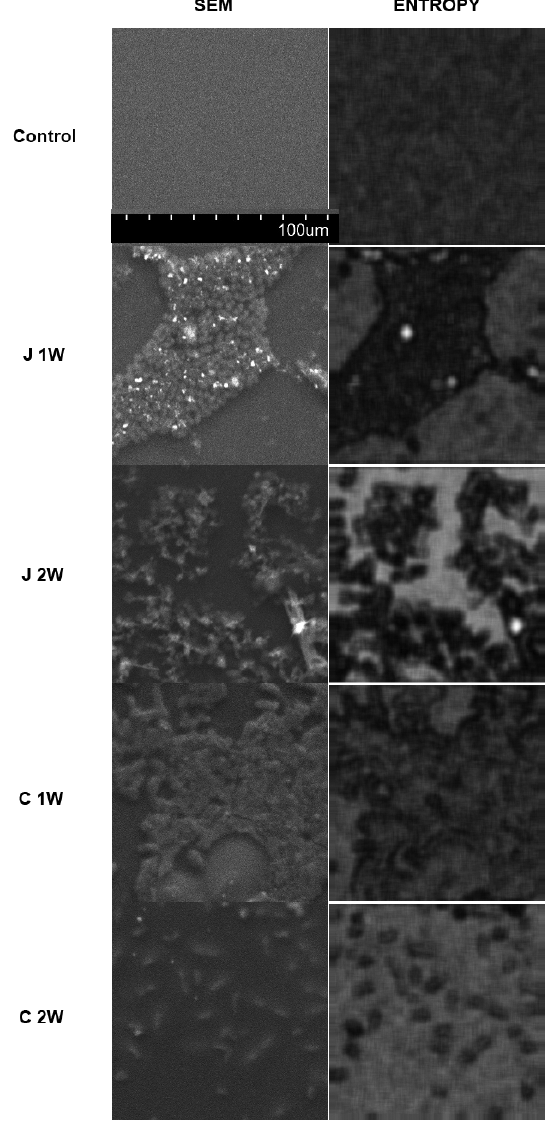
Figure 2. Investigation of surface structures on orthodontic alignments using digital texture analysis. The left column shows images from scanning emission microscopy (SEM). The right column shows intensity maps of chaotic and nonorganized structures (Entropy)—the brighter the local areas, the higher the entropy of the site. In these maps, textures with organized structure have low entropy (dark fields) because their structure is not chaotic.